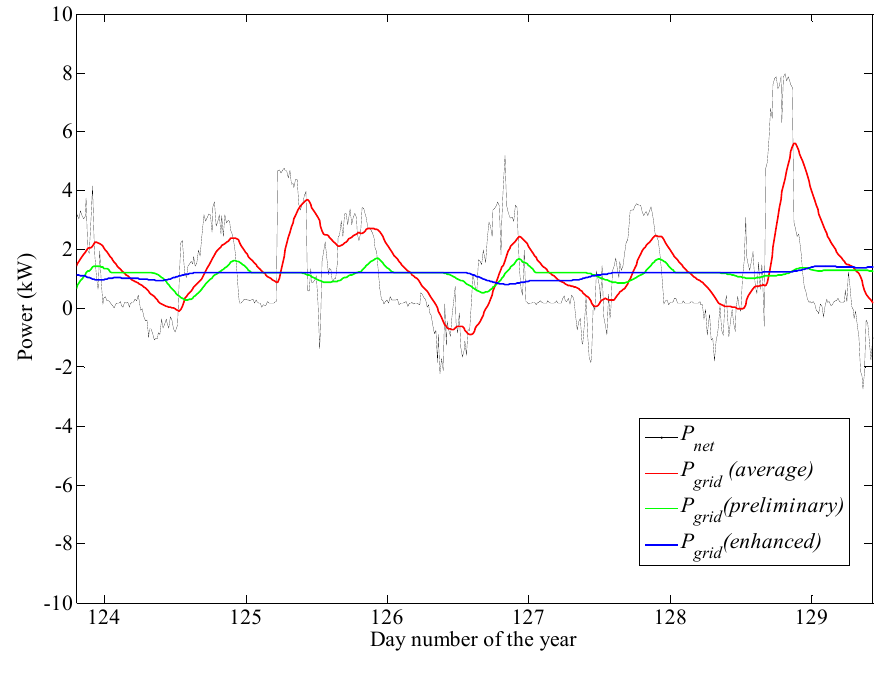
Figure 20. Power at the PCC during five days of operation for the no energy management system (EMS), P (black), for the simple moving average strategy, P net for the preliminary strategy, P (preliminary) (green), and for the enhanced proposed grid (enhanced) strategy, P grid